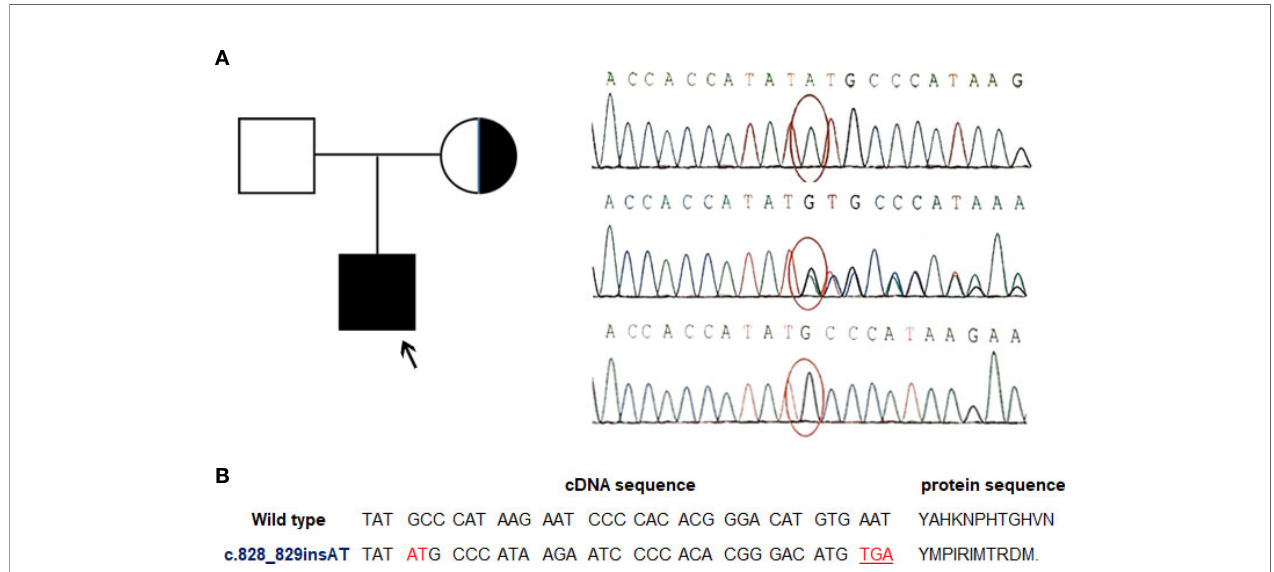
FIGURE 2 | A novel MAGT1 mutation identi fi ed in the current patient. (A) Family pedigree and DNA sequence chromatograms of the affected child and his parents. The proband was indicated by arrow. Con fi rmations of the in-frame insert mutation in MAGT1 by Sanger sequencing in the proband (top), his mother (middle), and his father (bottom). Nucleotide mutation site is marked with red circle. Reference sequence for MAGT1 gene: NM_032121.5 (B) Overview of the identi fi ed mutation. The c.828_829insAT mutant leads to a premature termination codon and generates a truncated MAGT1 protein